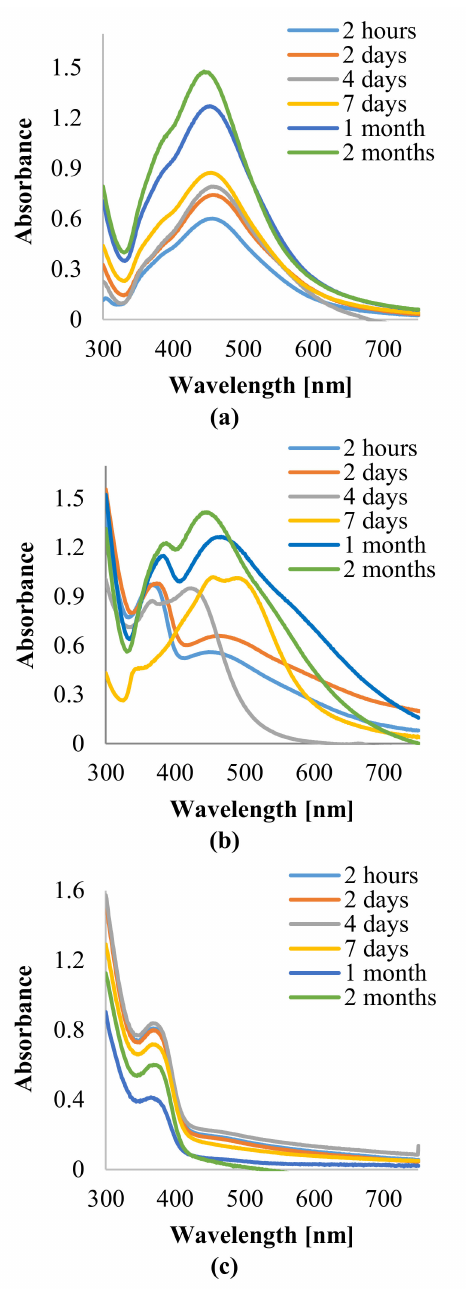
Figure 1. Absorption spectra of AgNPs prepared with the use of a C. incanus leaves extract ( a ) 5 mL, ( b ), 10 mL, ( c ) 15 mL recorded at various time